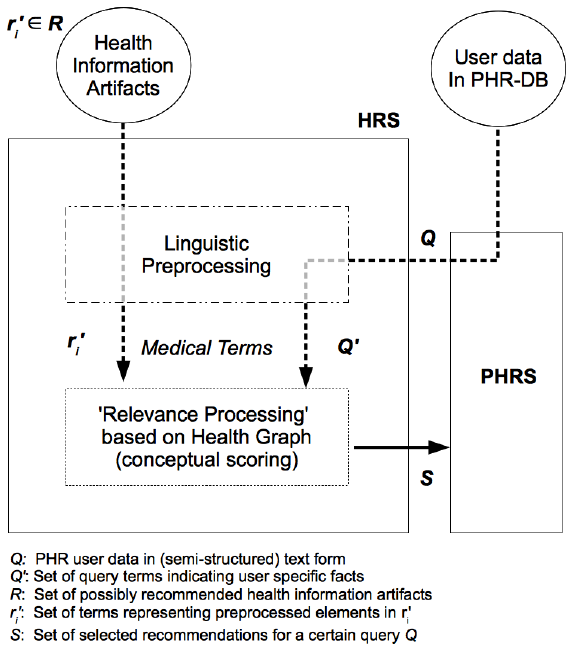
Figure 2. Basic architecture of a proposed HRS. It interacts with a PHR system’s database to obtain medical facts to compute individual relevance on the basis of G .